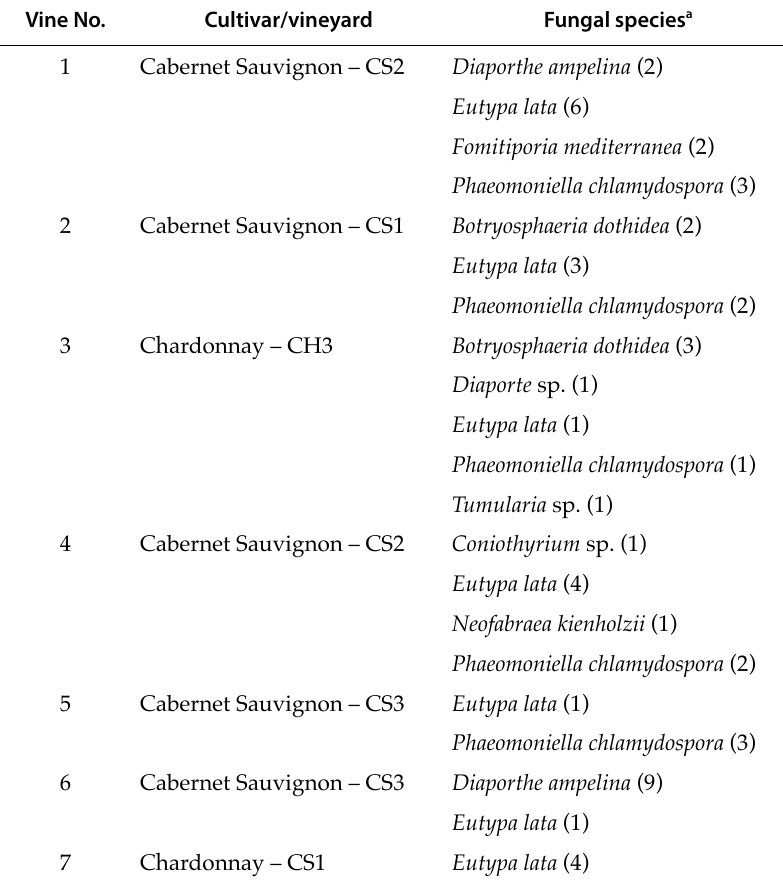
Table 3. Fungi isolated from trunk woody tissues of grapevines severely affected by grapevine trunk diseases in spring